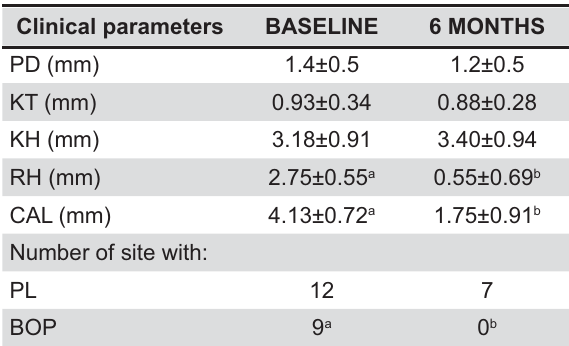
Table 1- Clinical parameters at baseline and at 6 months (cid:2)(cid:3)(cid:4)(cid:5)(cid:6)(cid:7)(cid:8)(cid:9)(cid:6)(cid:9)(cid:10)(cid:2)(cid:11)(cid:11)(cid:12)(cid:7)(cid:13)(cid:9)(cid:14)(cid:15)(cid:4)(cid:15)(cid:9)(cid:10)(cid:5)(cid:16)(cid:7)(cid:17)(cid:2)(cid:13)